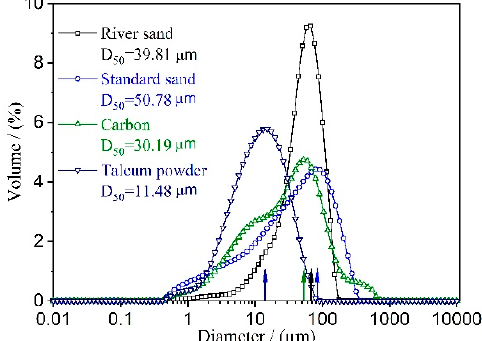
Figure 2. Particle size distribution of raw materials. Table 1. Chemical composition of raw materials.